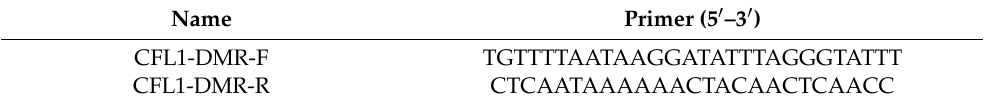
Table 4. Primer information for